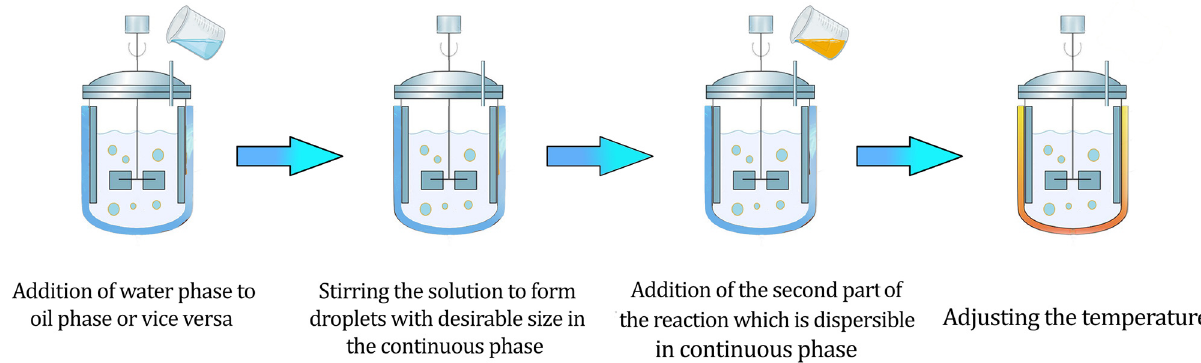
Figure 3: Preparation of polyurea micro - /nano - capsule via bulk emulsion